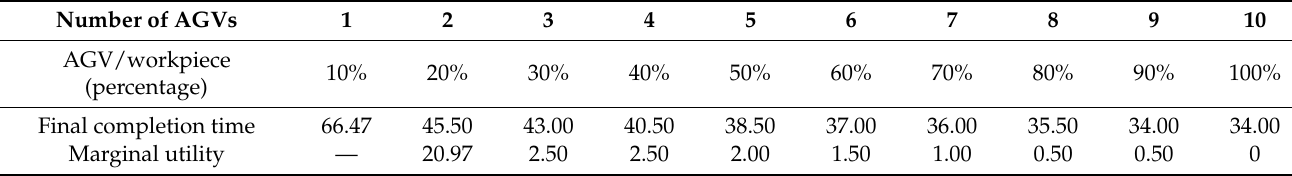
Table 4. AGV marginal